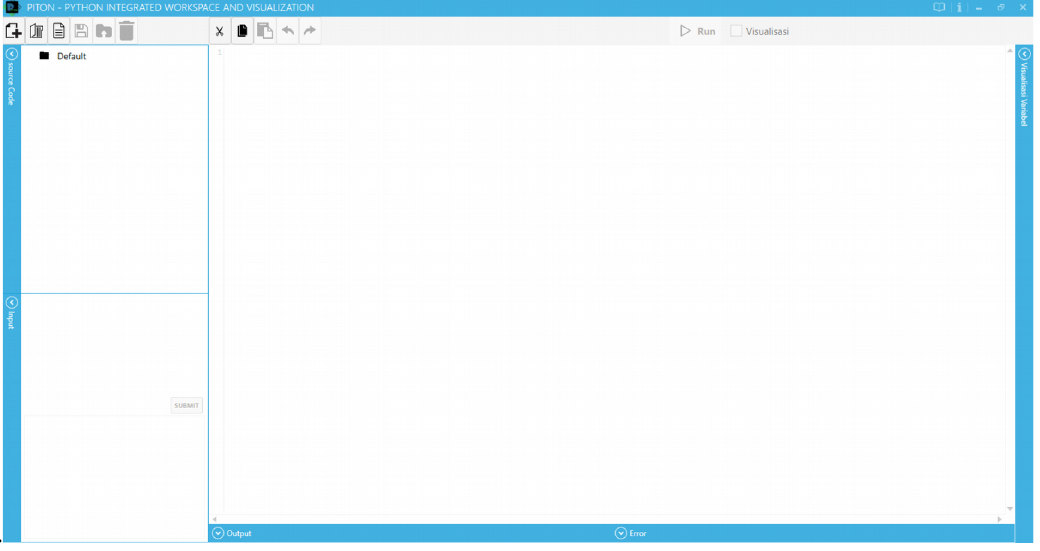
Figure 1. Default user interface of PITON